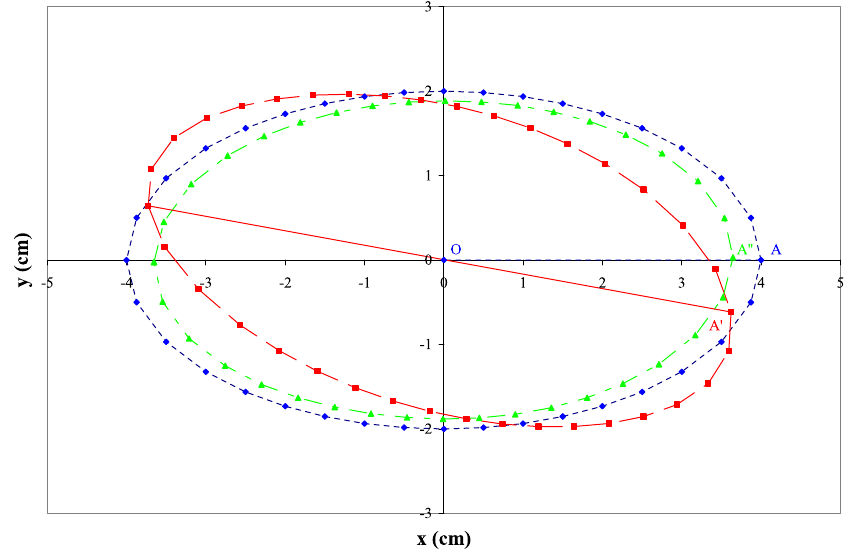
FIG. 20. (Color) Extracted beam profiles through the existing and modified